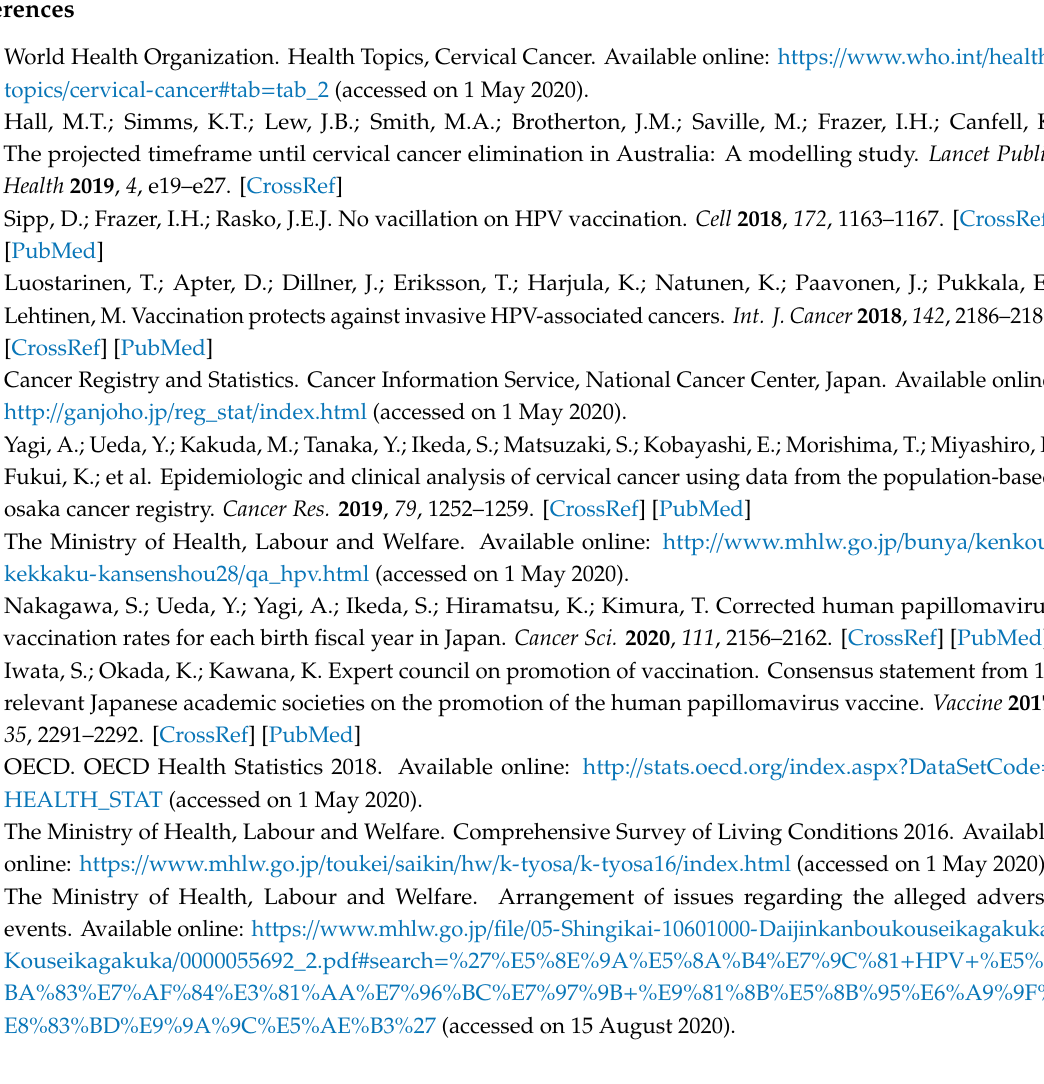
Figure S1: Survey flow, Figure S2: Leaflet contents, Figure S3: Image of leaflets (Only displayed in Japanese). Author Contributions: A.Y., Y.U., T.M. (Tatsuo Masuda), S.I., T.M. (Takashi Miyatake), S.N., K.H., T.N., E.M., T.E. and T.K. analyzed the data. A.Y. wrote the manuscript. All authors have read and agreed to the published version of the